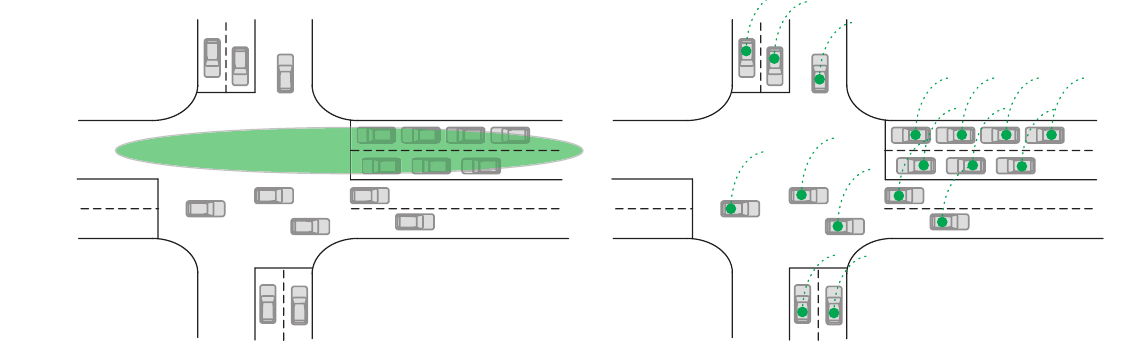
Figure 4: Real-time high-precision trajectory detection. Table 1: Example of raw data for a wide-area radar